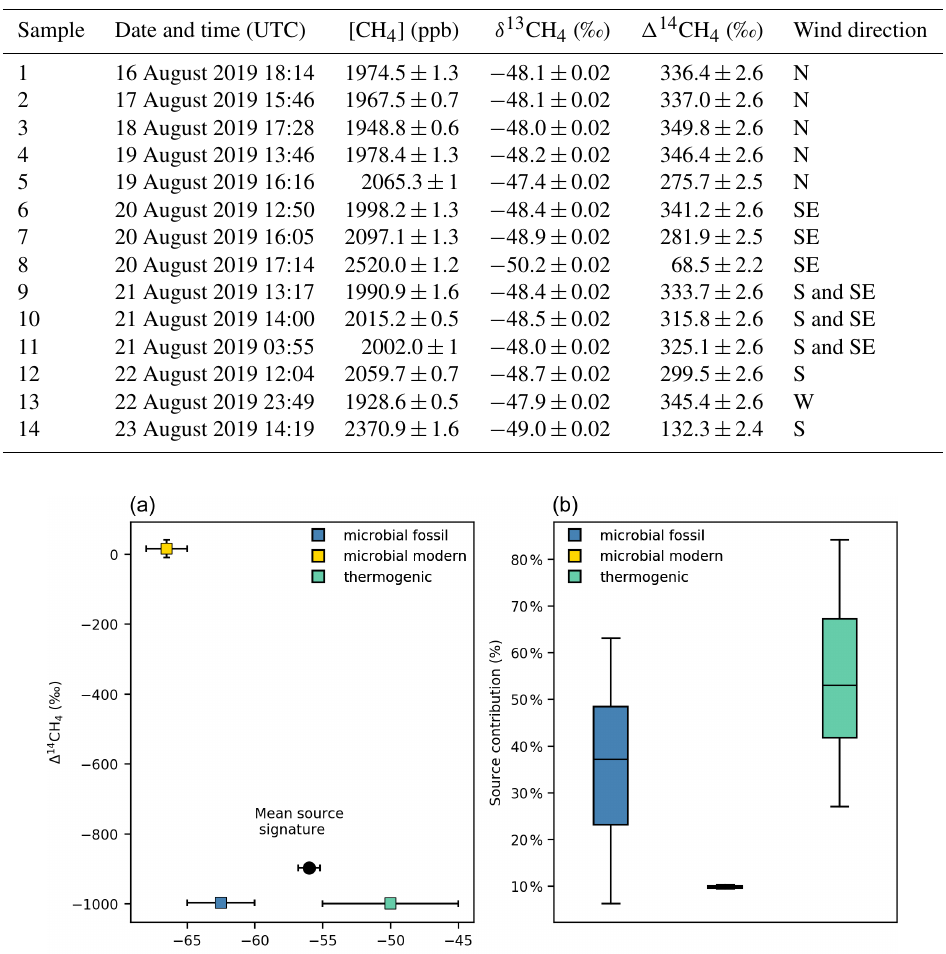
Table 2. Methane mole fraction [CH 4 ], δ 13 CH 4 , and (cid:49) 14 CH 4 of air samples collected in the Athabasca oil sands region in August 2019. Note that local time of sampling (mountain time, MDT) is 6h behind UTC universal time.